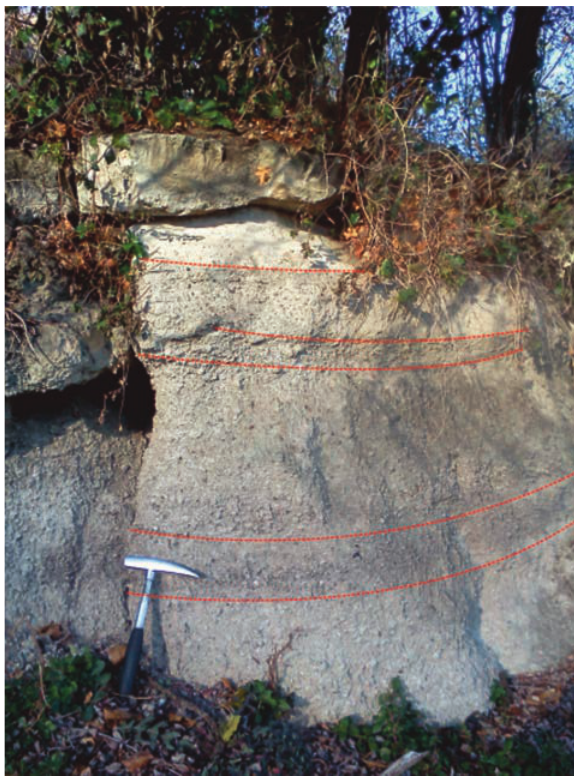
Figure 3. Pseudo-stratified Sorano unit I .